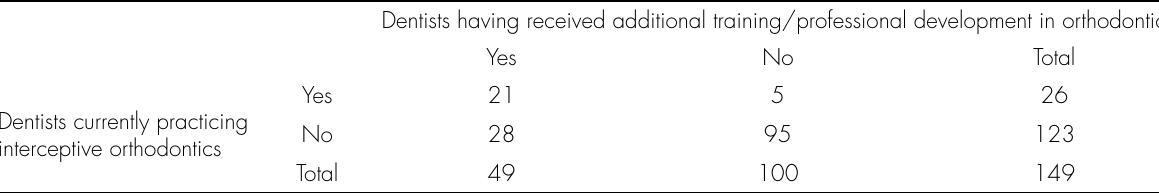
Table I. General dentists’ current practice of interceptive orthodontics versus training in interceptive orthodontics *† .